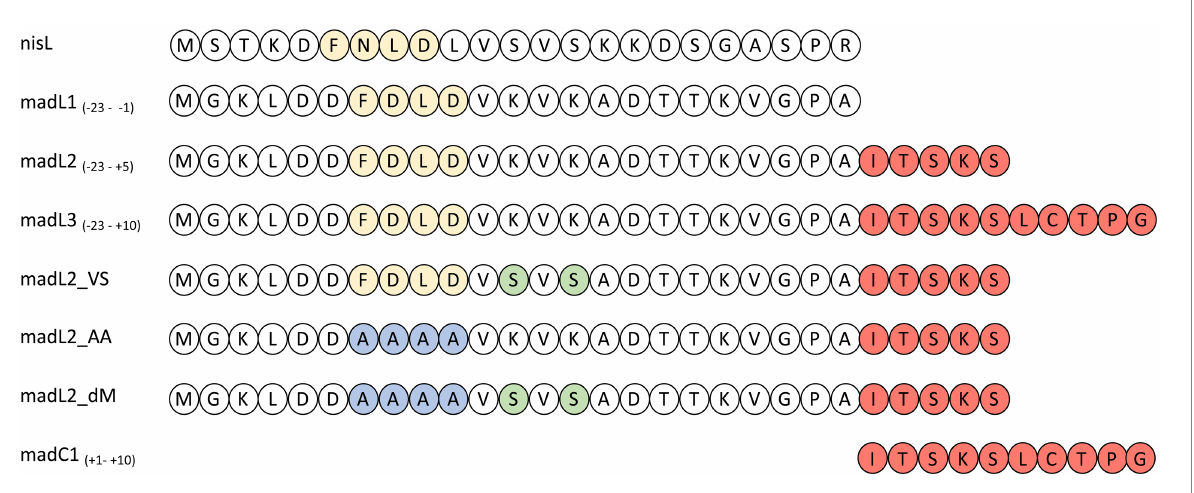
FIGURE 9 Overview of nisin LP (nisL) and maddinglicin leader variants (madL1-3, madC1, madL2_VS, madL2_AA, madL2_dM). The recognition box (-FxLD-) of the PTM enzymes is colored in light yellow. The amino acids from the CP are colored in light red. The one-letter code for amino acids was used. In the constructs the mutation of the FDLD-motif into-AAAA-is highlighted in blue and the mutations from lysine to serine are highlighted in light green.